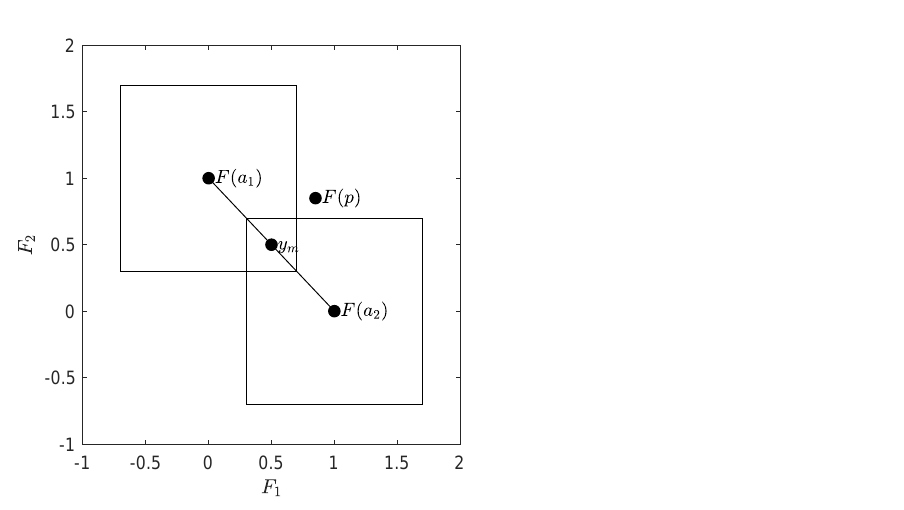
Figure 3. Linear Pareto front with slope − 1. If for N = 2, the archive is given by A = { a 1 , a 2 } such that F ( a 1 ) and F ( a 2 ) are the end points of the Pareto front, then the Hausdorff distance of A and the Pareto front is given by h = (cid:107) F ( a 1 ) − y m (cid:107) ∞ , where y m is the arithmetic mean of F ( a 1 ) and F ( a 2 ) . For ∆ < 2 h , there may exist candidate solutions p that will be considered by the archive (line 5 of Algorithm 1) but discarded in the same step (lines 23 to 26 of Algorithm 1), leading to an increase of ∆